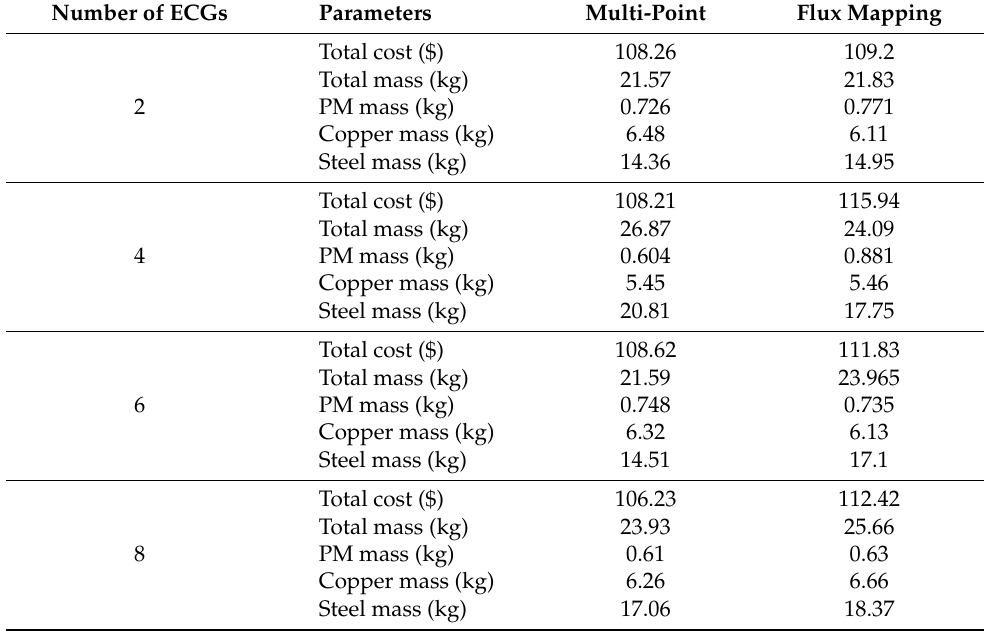
Table 6. Evaluation of optimisation method